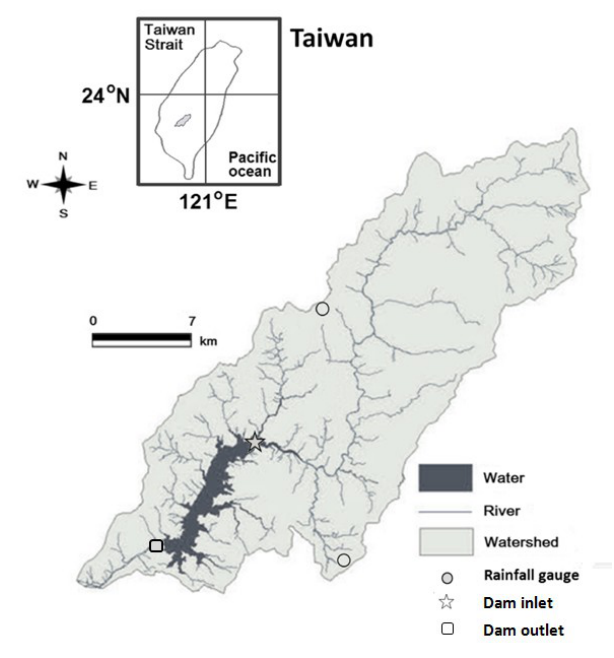
Figure 1. Map of the Tsengwen Reservoir